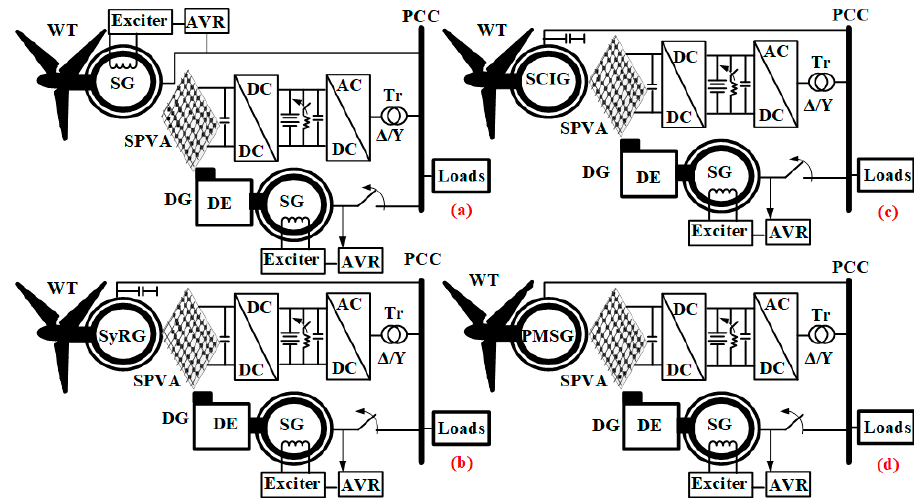
Figure 4. Off-grid configurations having SPVA, DE driven SG and WT driven: ( a ) SG, ( b ) SyRG, ( c ) SCIG, and ( d ) PMSG.